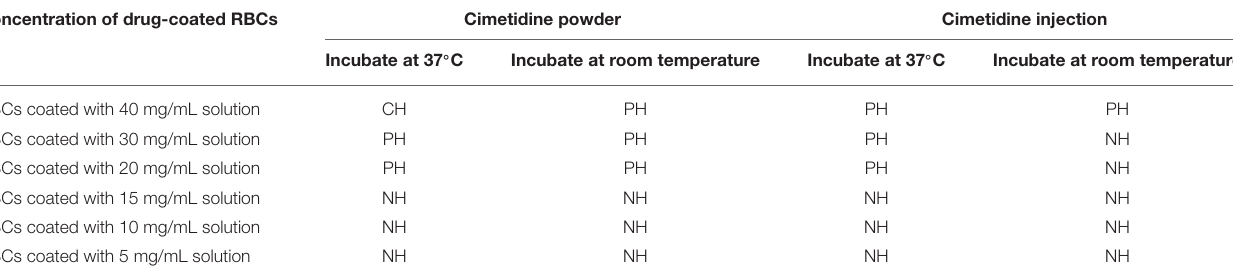
TABLE 3 | Appearance of cimetidine-coated RBCs prepared by mixing different dosage forms and different concentrations of cimetidine with O-type RBCs and incubating at 37 ◦ C or room temperature for 1h. Concentration of drug-coated